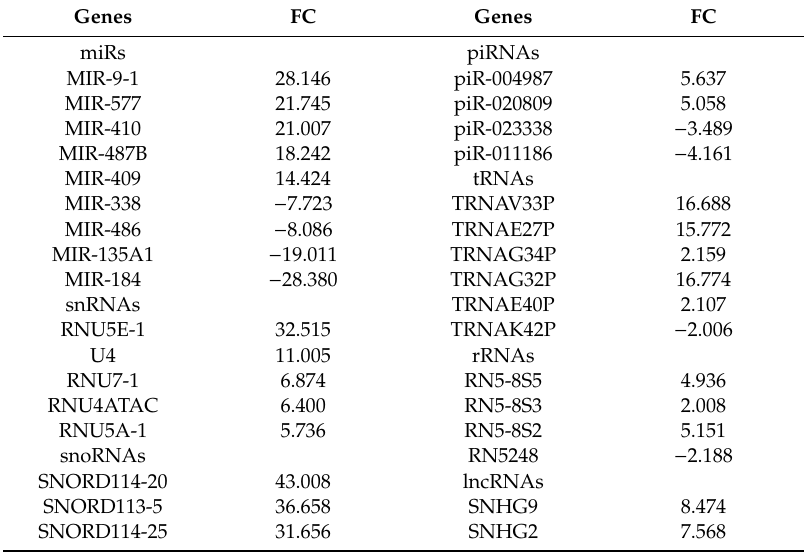
Table 3. Fold-change (FC) of top 65 altered ncRNAs in bronchial epitheliums of sputum of lung cancer patients versus controls